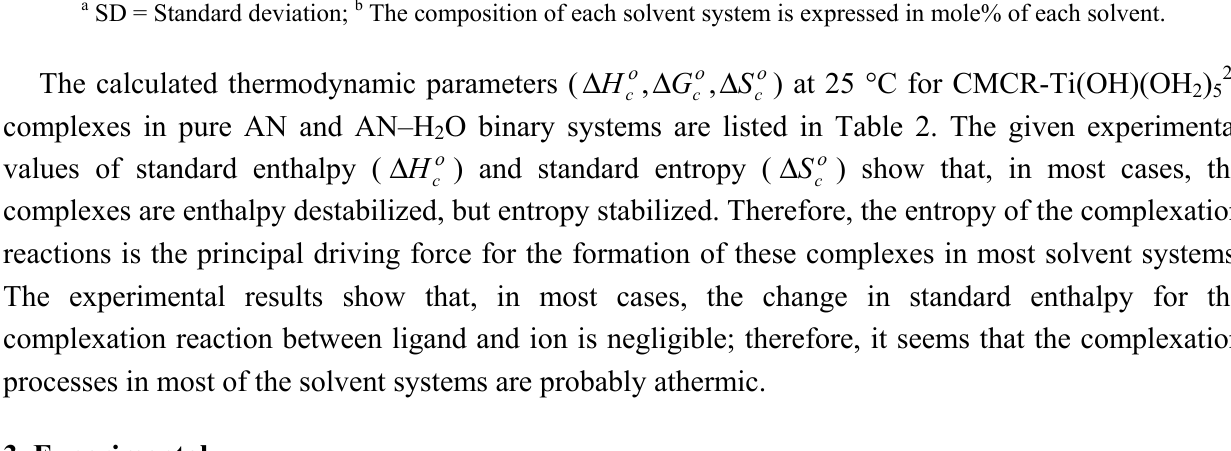
) 52+ complexes in 2